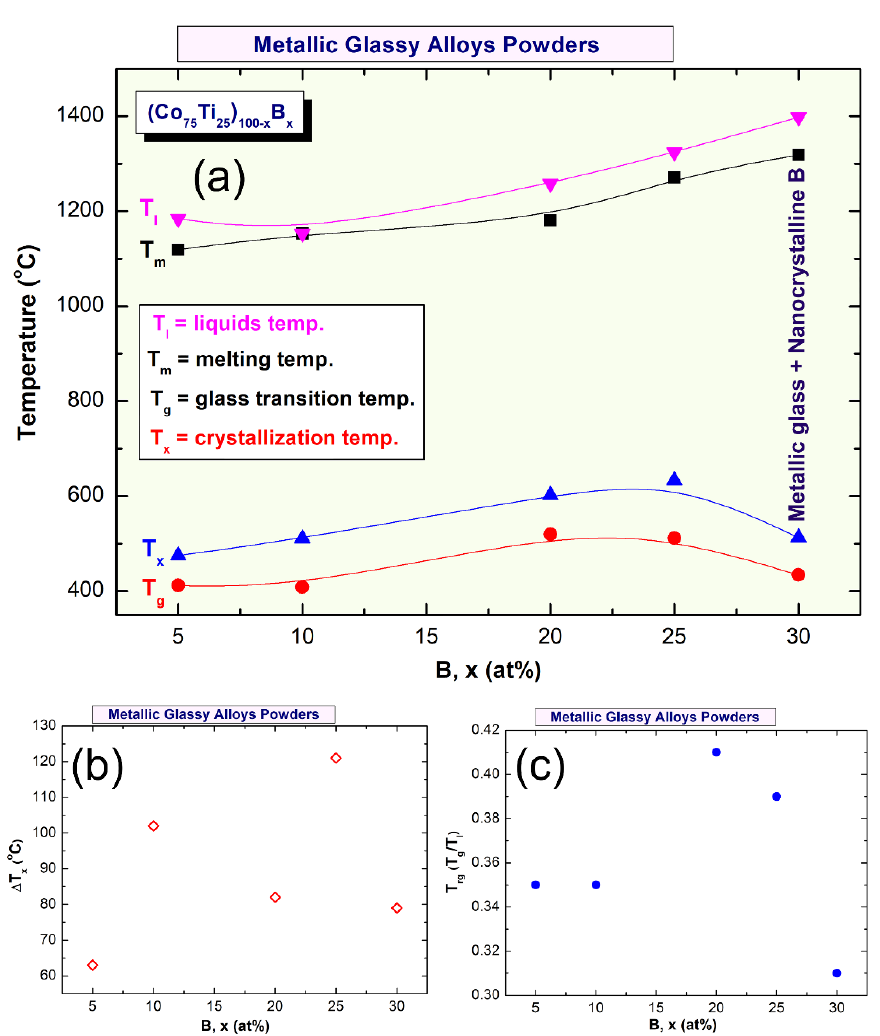
Figure 9. ( a ) Dependence of T g , T x , T m , and T l on B molar fraction of (Co 75 Ti 25 ) 100 − x B x metallic glass system. The correlation between ∆ T x and T rg and B content are shown in ( b ) and ( c ), respectively.